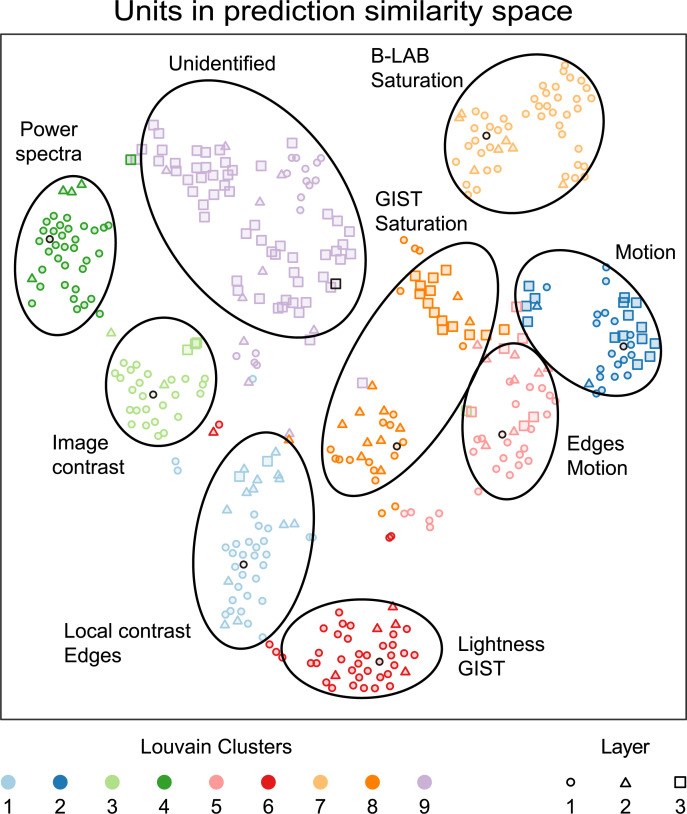
tSNE plot showing all 420 units of the three convolution layers in eighteen-dimensional predictor space.The units are colour coded showing nine Louvain clusters. We manually assigned labels to the clusters, that correlate well with specific image features or predictors. The centre of each cluster, defined by the largest mean weight with the units in the cluster, has a black outline.